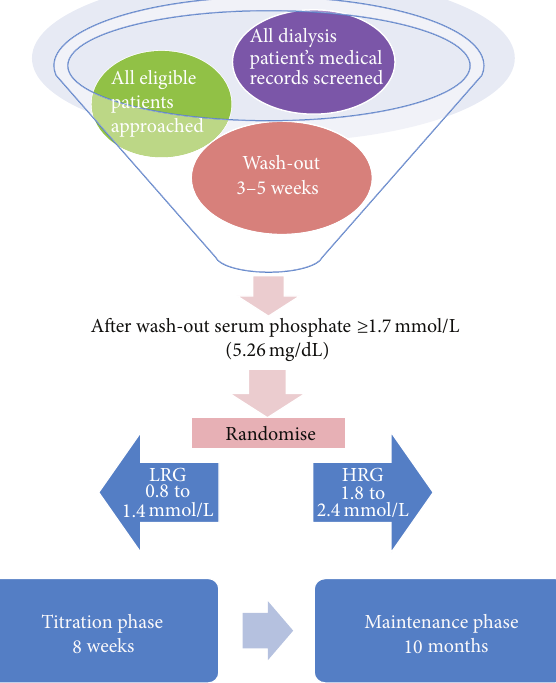
Figure 1: Recruitment and